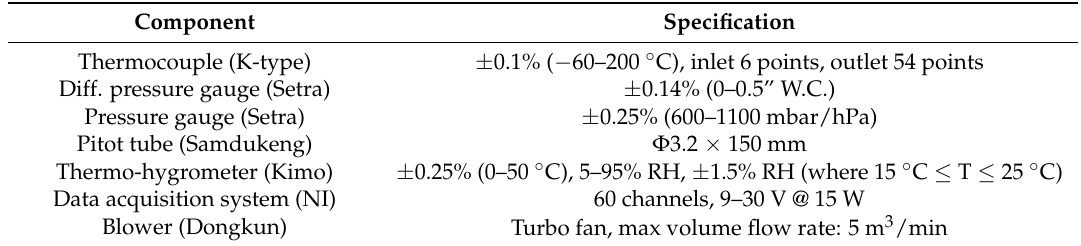
Table 2. Specification of PTC heater experimental apparatus.